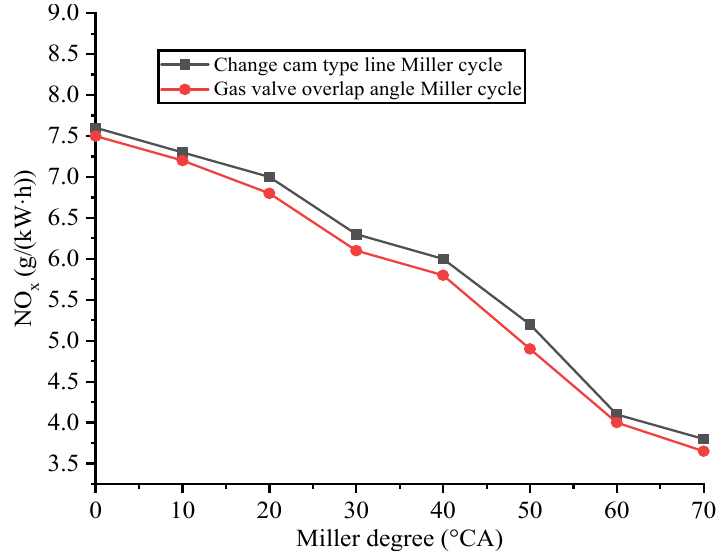
Figure 10. The NO x emission